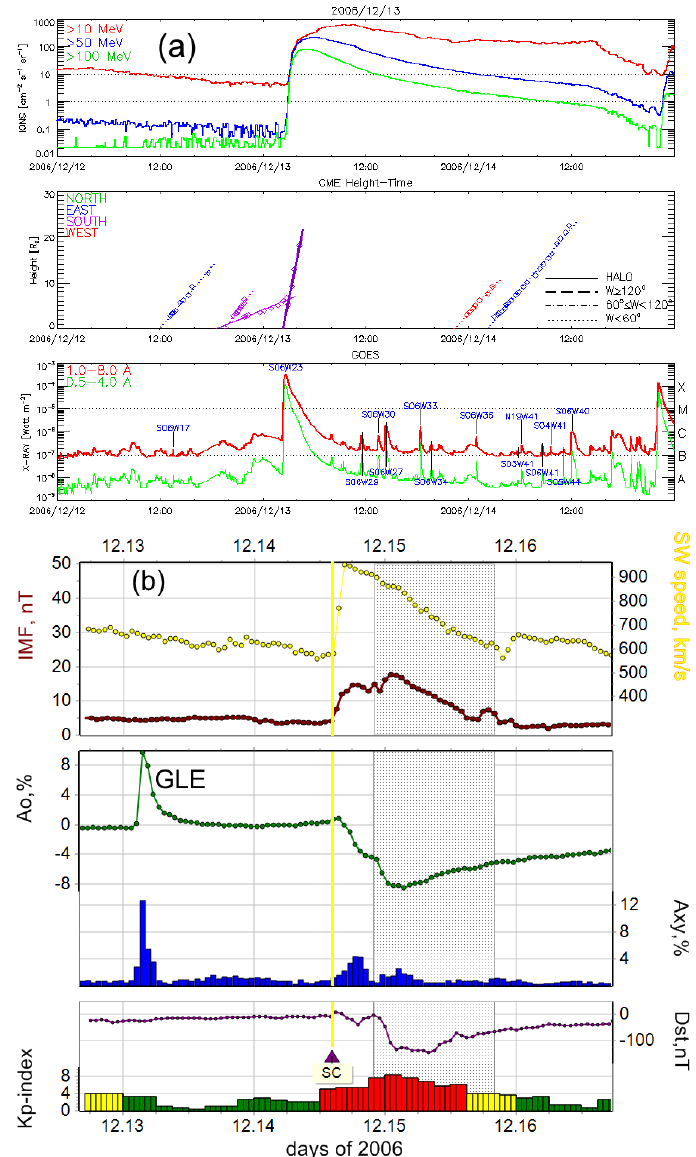
Figure 3. An example of an event from the GLE group: ( a ) PHTX (taken from SOHO/LASCO CME Catalog); ( b ) behavior of the main SW, IMF, CR, and GA parameters during the FD on 14–15 December